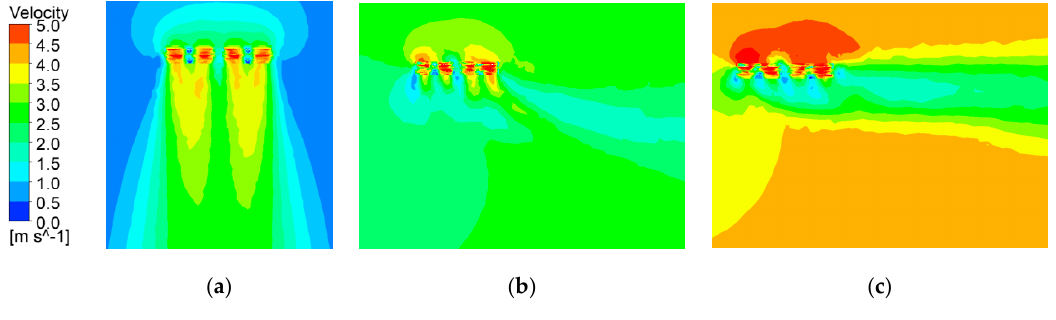
Figure 12. Velocity distribution: ( a ) 0 m/s; ( b ) 2.5 m/s; ( c ) 4.0 m/s.